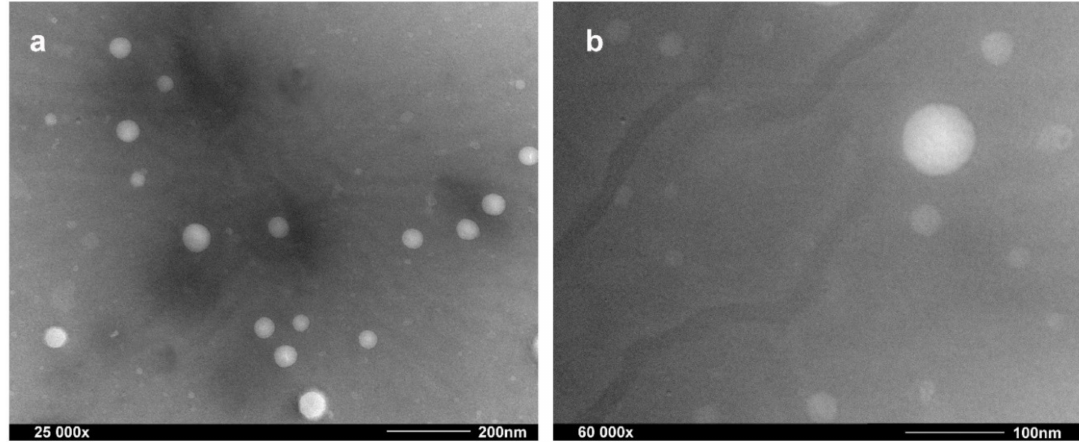
Figure 1. Transmission electron microscope (TEM) micrograph of astaxanthin-loaded nanoliposomes. ( a ) was magnified 25,000 × ; and ( b ) was magnified 60,000 ×